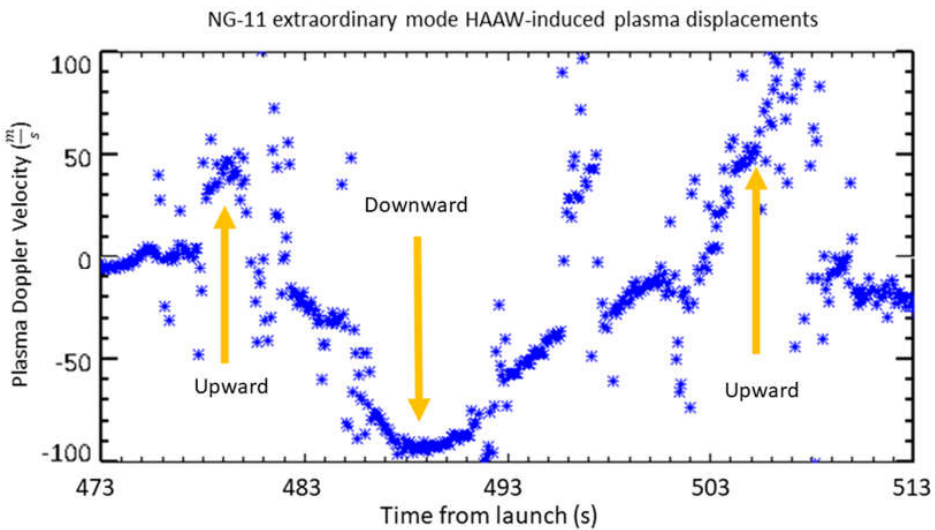
Figure 2. Doppler velocity plot of fixed frequency X-mode observations beginning at 20:54 UTC. Upward and downward plasma displacement peaks are identified.